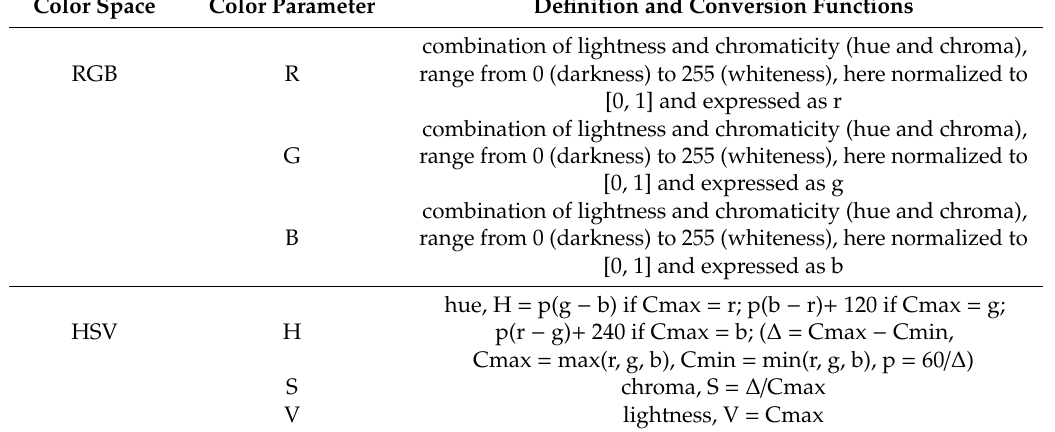
Table 2. Definition and conversion functions of each color parameter in the five color space models. Color Space Color Parameter Definition and Conversion Functions combination of lightness and chromaticity (hue and chroma), RGB R range from 0 (darkness) to 255 (whiteness), here normalized to [0, 1] and expressed as r combination of lightness and chromaticity (hue and chroma), G range from 0 (darkness) to 255 (whiteness), here normalized to [0, 1] and expressed as g combination of lightness and chromaticity (hue and chroma), B range from 0 (darkness) to 255 (whiteness), here normalized to [0, 1] and expressed as